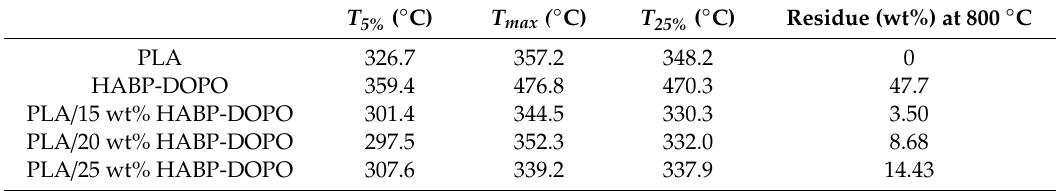
Figure 2. TGA and DTG curves of HABP-DOPO, neat PLA and PLA/HABP-DOPO blends under nitrogen gas atmosphere. ( a ) TGA curves and ( b ) DTG curves. Table 2. Thermal properties of HABP-DOPO, neat PLA and PLA/HABP-DOPO blends.